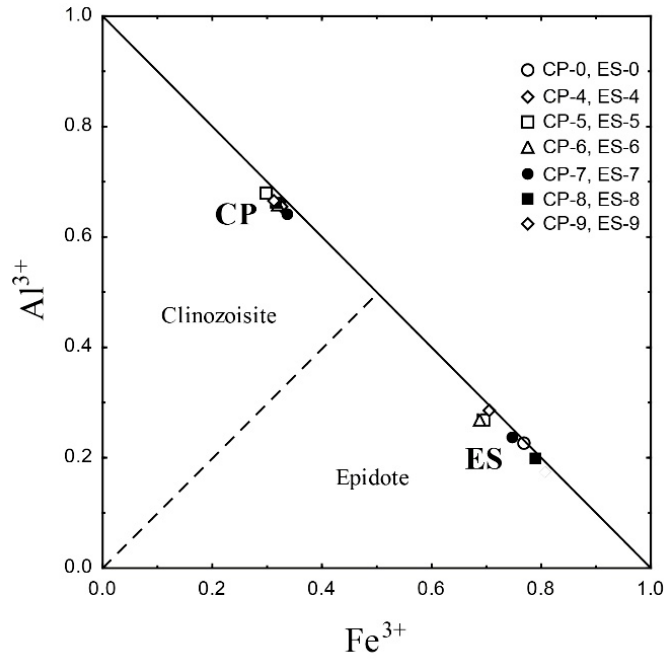
Figure 3. Diagram of Al-Fe 3+ substitution in studied samples. Epidote was M 3 Fe 3+ -dominant in contrast to Al-dominant clinozoisite samples, as documented by the different positions of ES and CP analyses in the diagram. Table 6. Unit-cell parameters of pyroxene as a breakdown product after the heat treatment of epidote (ES) and clinozoisite (CP) compared to esseneite (Ess), diopside (Di), hedenbergite (Hd), aegirine (Aeg), and jadeite (Jd). Ref .